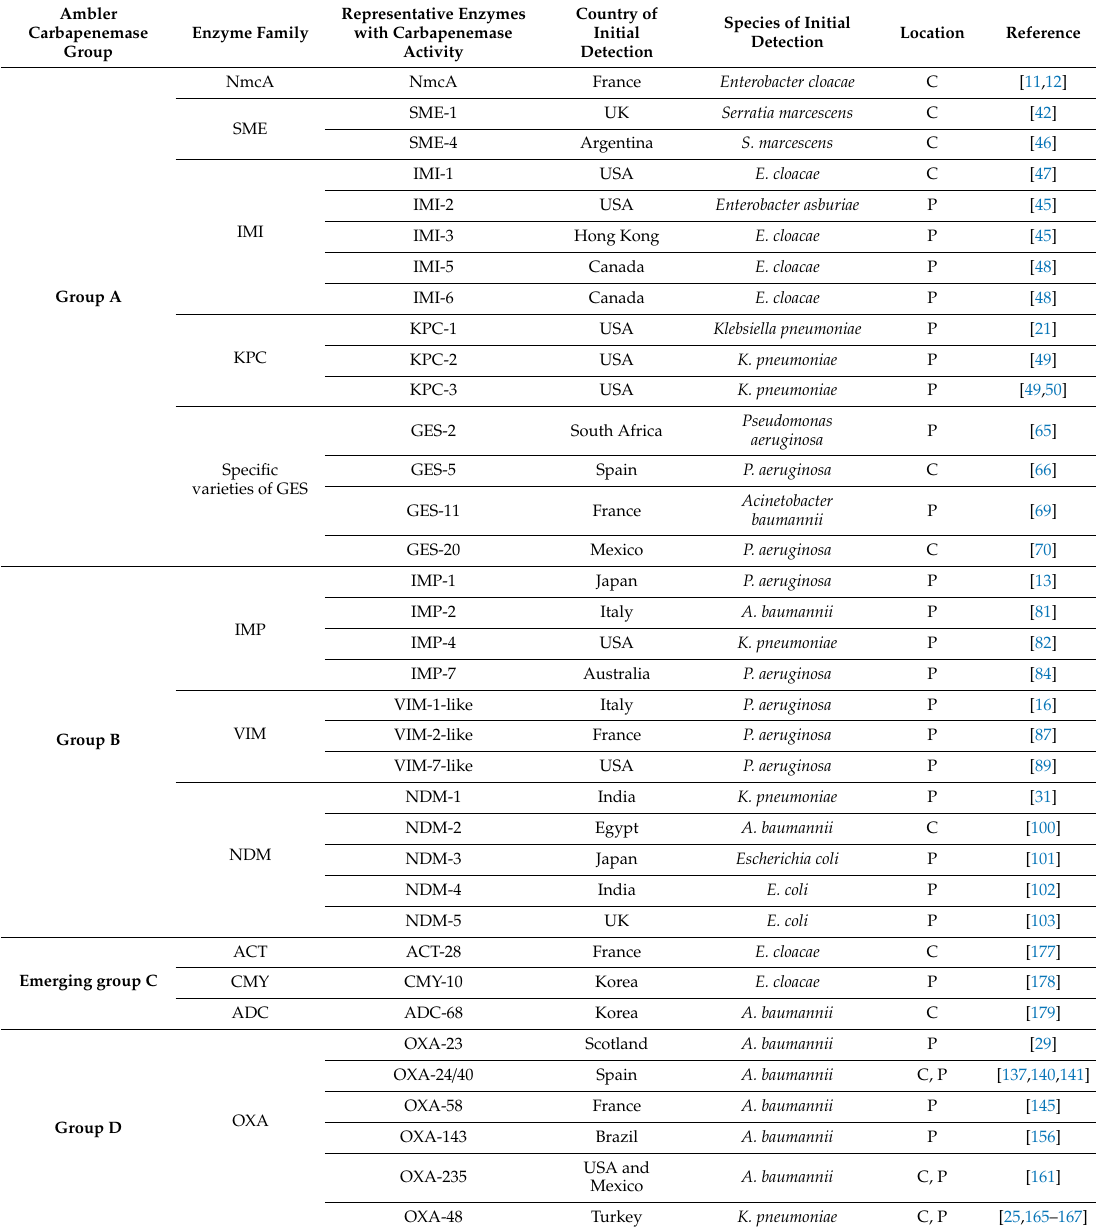
Table 1. Examples of carbapenemases with respective families, initial species, country of description, and genetic